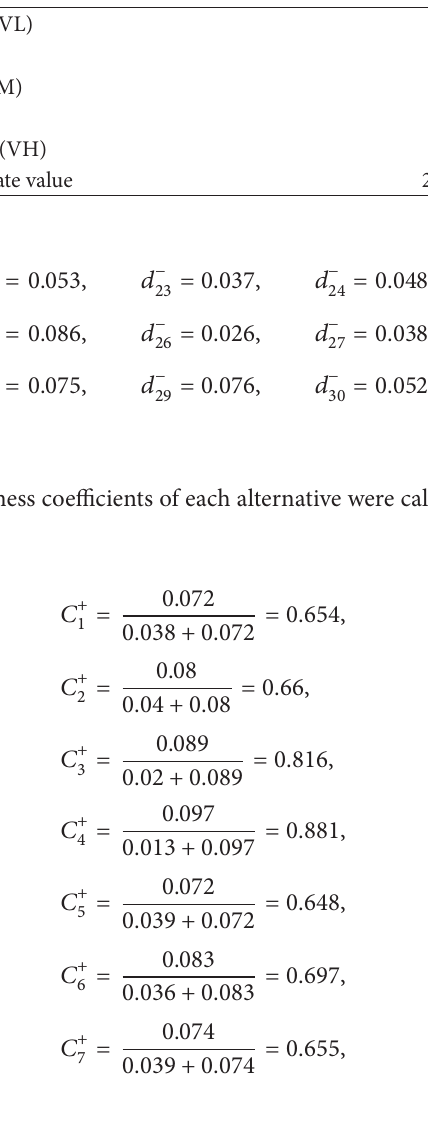
Table 6: Linguistic variables for the criteria